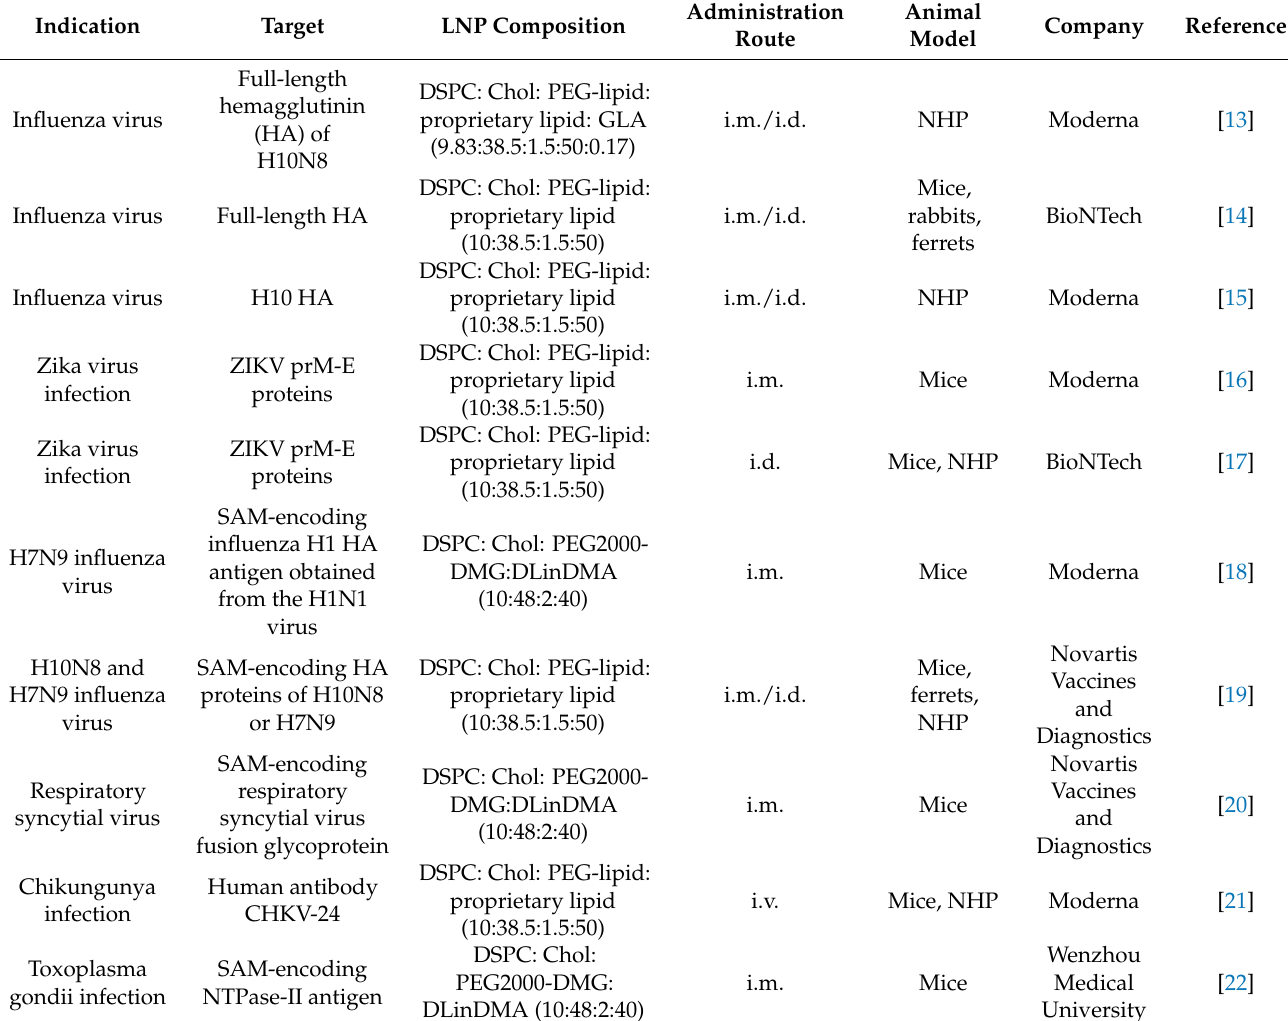
Table 1. LNP-based mRNA